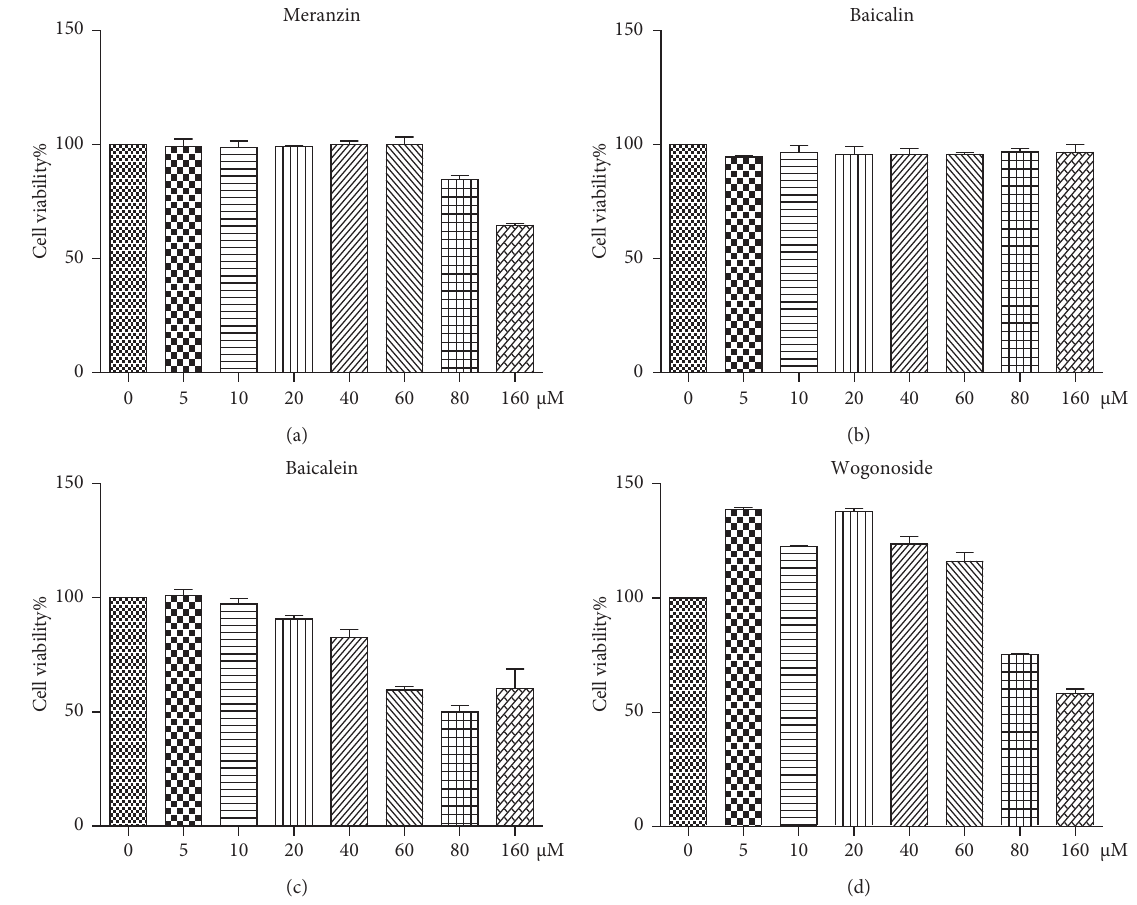
Figure 8: Cytotoxic activities of various concentrations (5, 10, 20, 40, 80, and 160 µ M) of meranzin, baicalin, baicalein, and wogonoside against RAW264.7 cells after 24h of treatment. Results are expressed as mean ± SD from three independent experiments ( n �